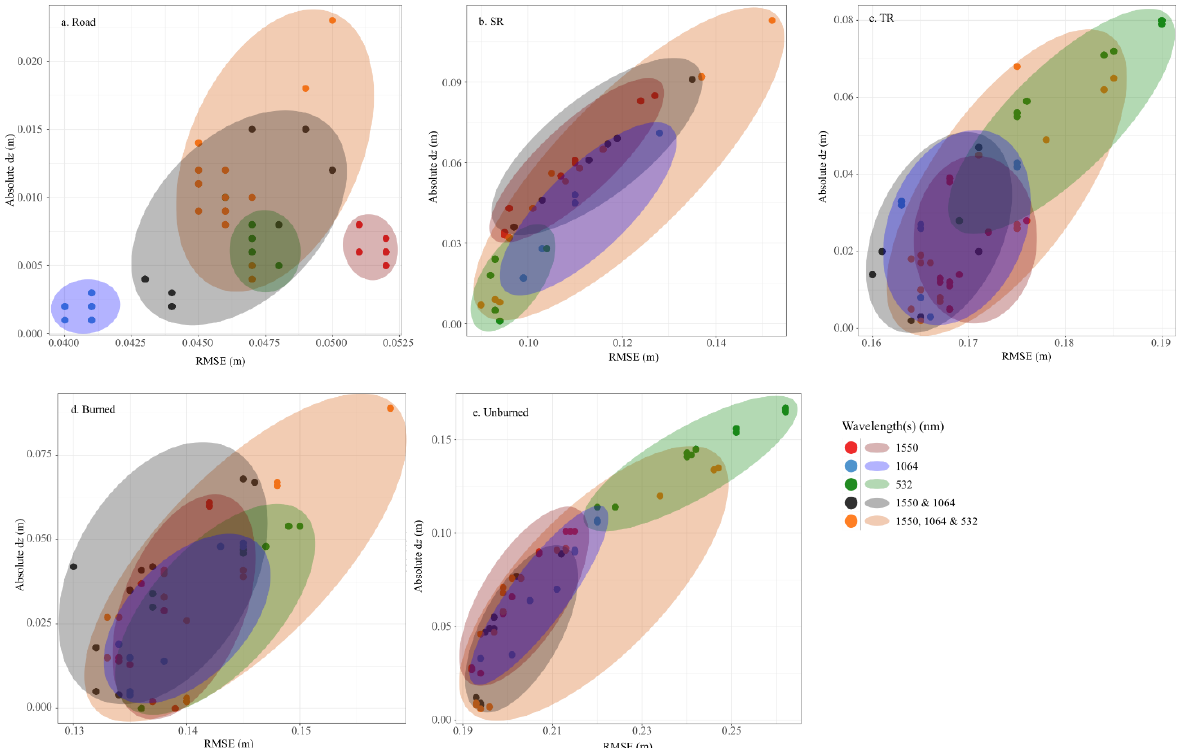
Figure 15 . Ground classification results by wavelength along/in: ( a ) roads, ( b ) burned peatlands with short regeneration, ( c ) burned peatlands with tall regeneration, ( d ) all burned peatlands, and ( e ) unburned peatlands two years post-fire. Results were identified using TerraScan as determined by lidar channel. Each point represents an iterative parameter set. Note: axis range varies by plot.